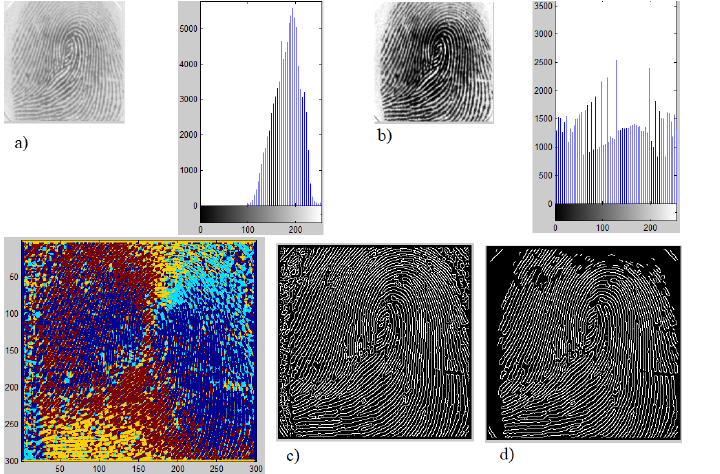
Figure 2. The result of image pre-processing of a fingerprint. ( a , b ) show the results of the equalization histogram and noise filter based on CNN, ( c , d ) show the results of edge detection and